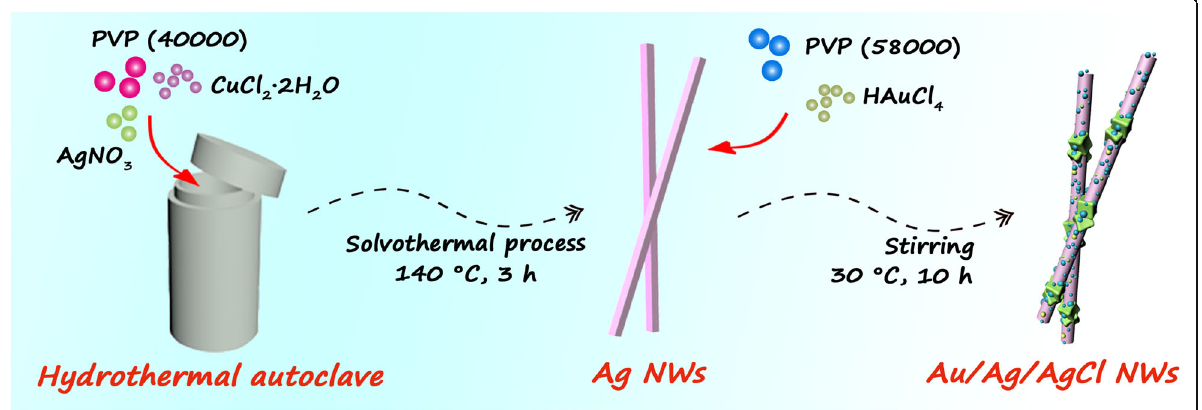
Fig. 1 Schematic illustration of the synthetic routes of 1D Ag/Au/AgCl hollow heterostructures